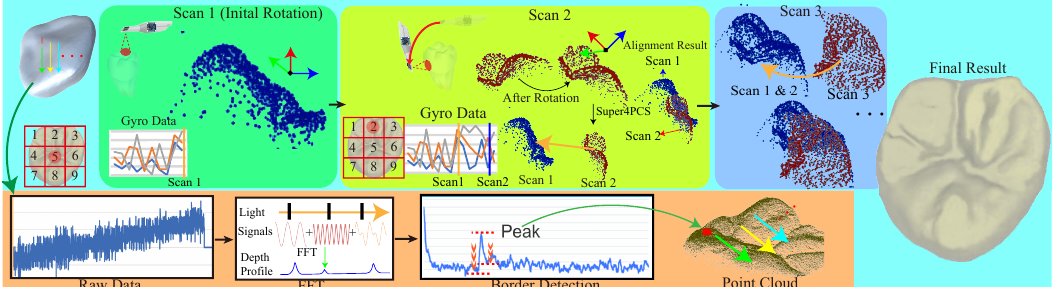
Figure 1. Our scanning process starts at a destined region of a tooth and advances it in a designed order. Each scan consists of injecting an infrared signal of various frequencies, of measuring frequency responses, of collecting depth responses using fast Fourier transform [18], and of volumetrically identifying the boundary. After the first scan, our system initiates the Super 4-point-congruent-set method (4PCS) [19] with the gyro-tracking orientation to align the newly scanned point cloud with the existing for immediate visualization. Finally, we can apply Poisson surface reconstruction [20] for the tooth